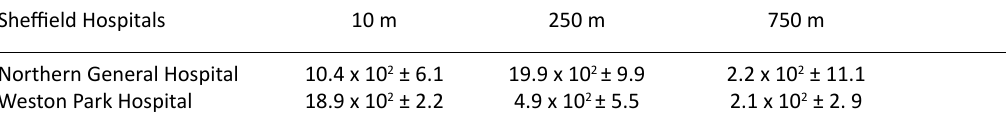
Table 2. Existence of MRSA in samples of soils collected near the hospitals in Sheffield Sheffield